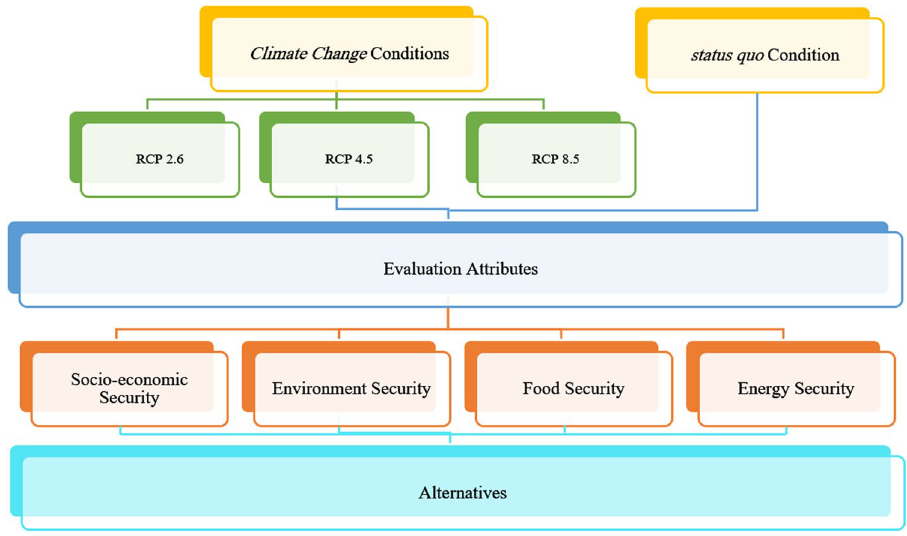
Figure 2. Schematic diagram of the MADM problem.